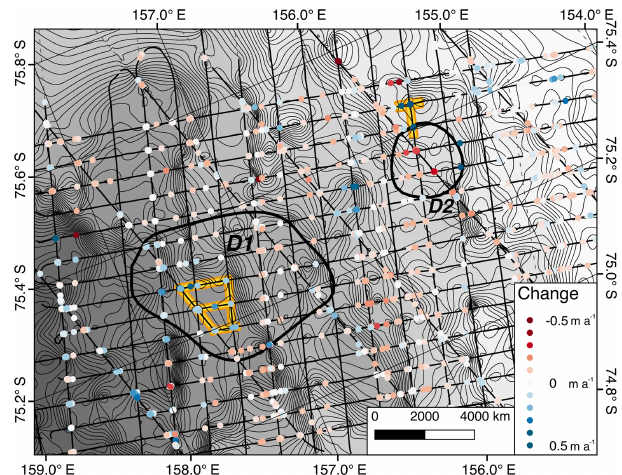
Figure 11. Observed time-normalized surface elevation changes are plotted on a DEM showing hydraulic potential with 10m contours for the region around lakes D1 and D2. Transect segments where this study observed correspondence between a hydraulic potential minimum and a time history of surface elevation change are high- lighted in